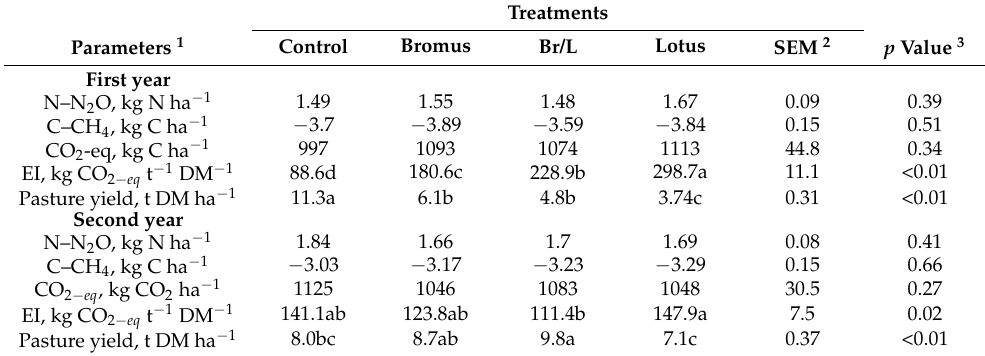
Table 4. Annual cumulative emissions of N–N 2 O, C–CH 4 and CO 2 − eq , pasture yield and emission intensity (EI) of different treatments during the first and second year of experiment. Treatments Parameters 1 Control